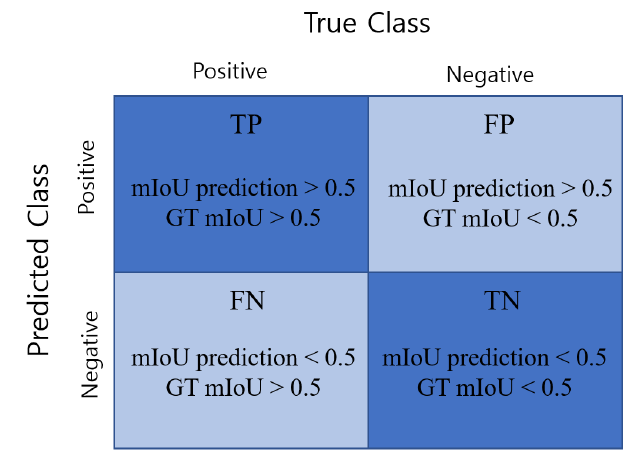
Figure 9. Confusion